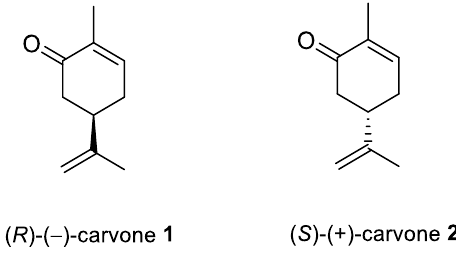
Figure 2. Stereoisomers of carvone.